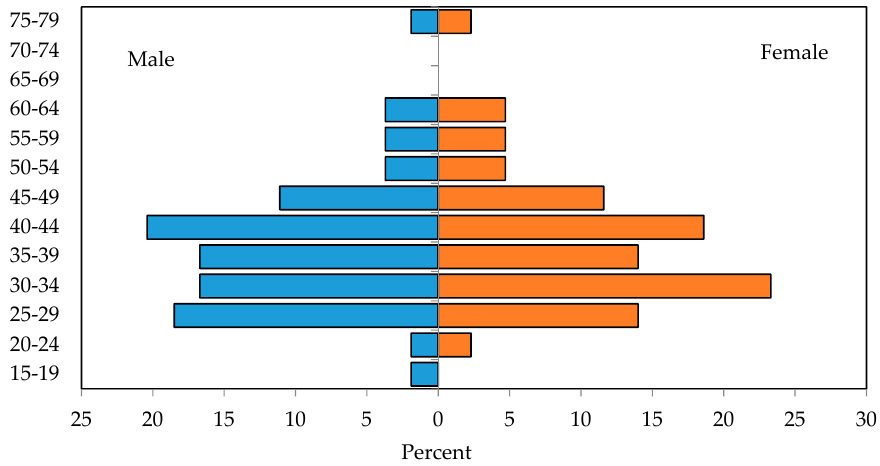
Figure 1. Relative distribution of survey participants grouped by gender and age.